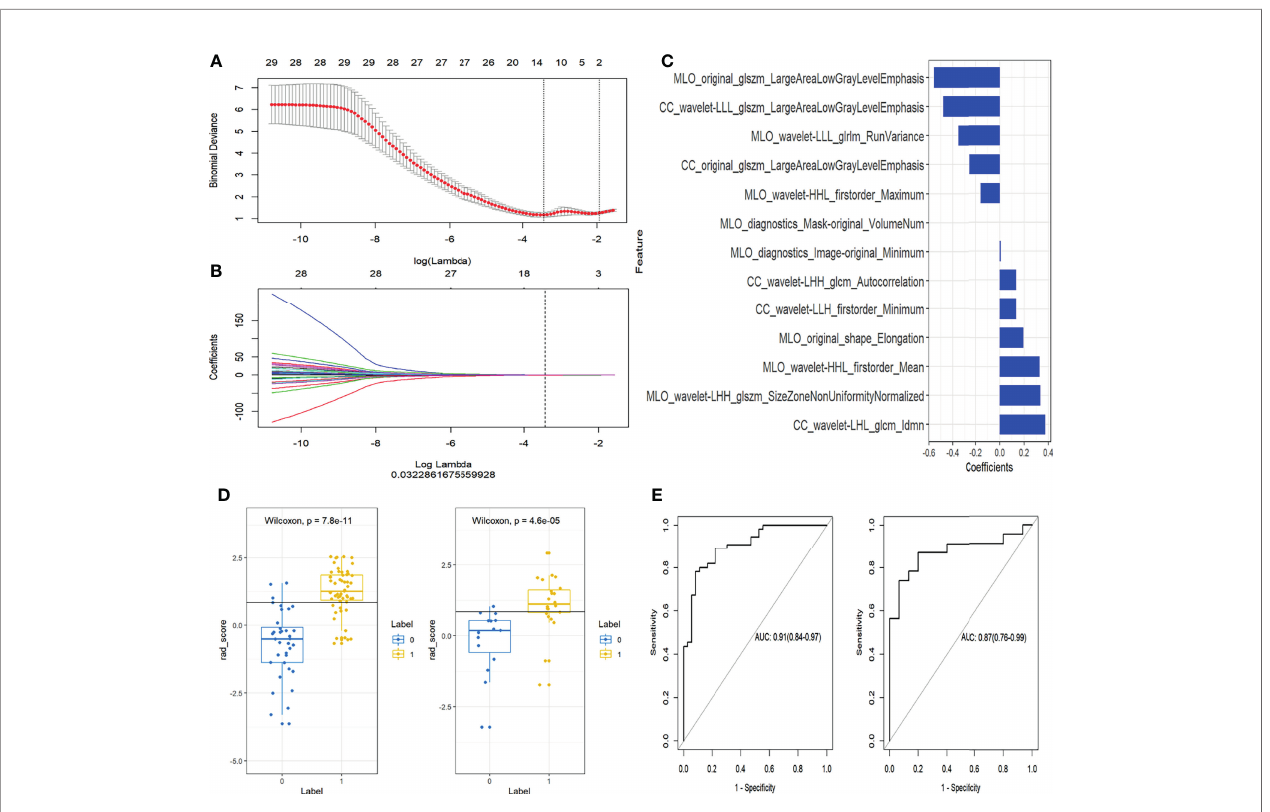
FIGURE 2 | Selection of radiomics features and evaluation of the prediction performance of the radiomics signature. (A) Selection of the hyperparameter ( l ) in the least absolute shrinkage and selection operator (LASSO) model via ten-fold cross-validation based on minimum error; vertical black dotted line, optimal value of l (best fi t). (B) Coef fi cients and log( l ) values; features with nonzero coef fi cients are shown. (C) The 13 features showing nonzero coef fi cients are displayed. The features utilized for constructing the radiomics signature are shown on the y-axis with the corresponding coef fi cients in LASSO Cox analysis on the x-axis. (D) Rad- scores of benign and malignant masses in the training and test groups. Yellow and blue represent the actual classi fi cation: the greater the separation of yellow and blue, the better the rad-score ’ s predictive accuracy. (E) Receiver operating characteristic (ROC) curves of the radiomics signature in the training and test set.